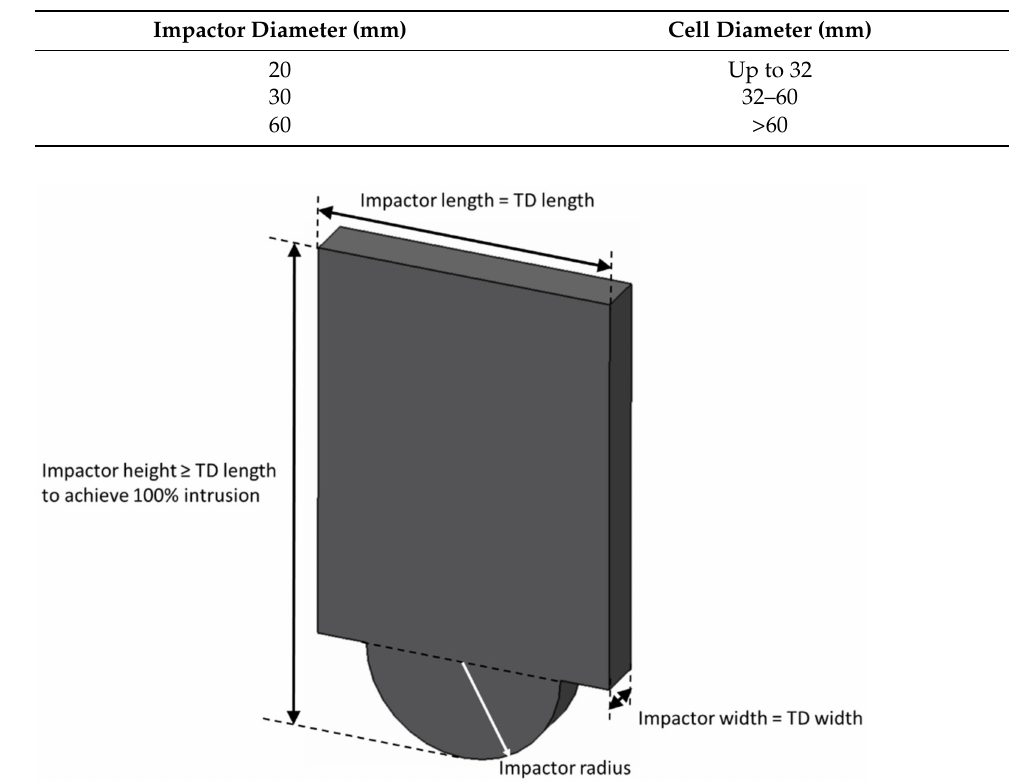
Table 6. Recommended impactor diameter for crushing cylindrical cells as per SAND2017- 6925:2017 [107].